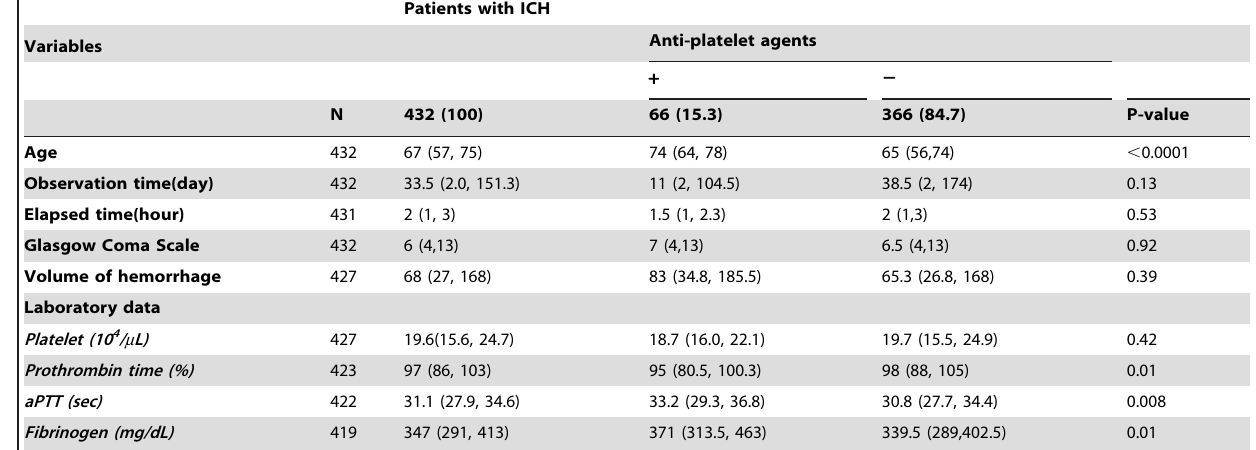
Table 2. Patient characteristics.